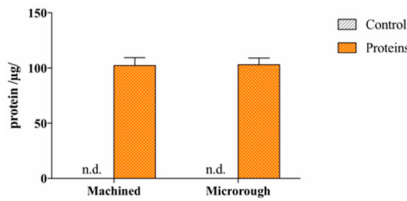
Figure 1. Serum protein adsorption. Amount of firmly adsorbed serum proteins to machined or microrough titanium surfaces 1 h after incubation at 37 ◦ C and 5% ppCO